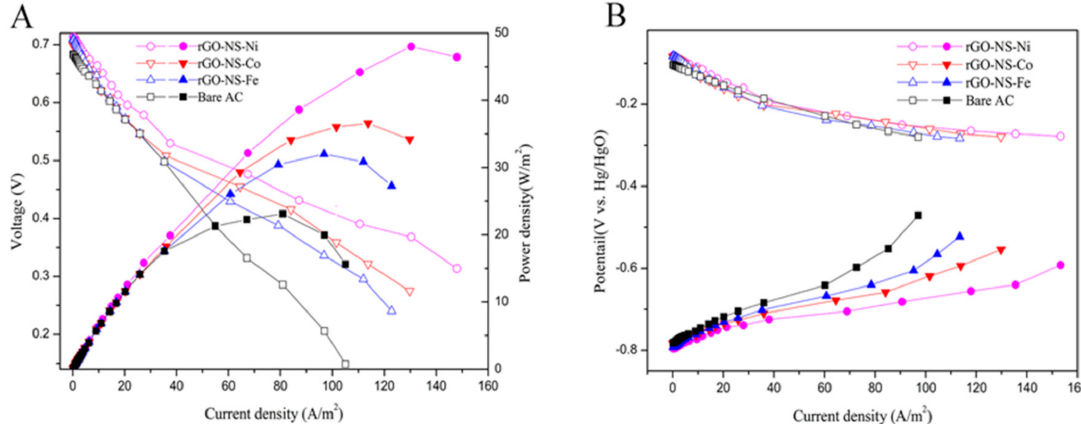
Figure 5. ( A ) Power density curves of the direct glucose alkaline fuel cell (DGAFC) equipped with different rGO-NS-M anodes. ( B ) Polarization curves of cathode and different anodes.